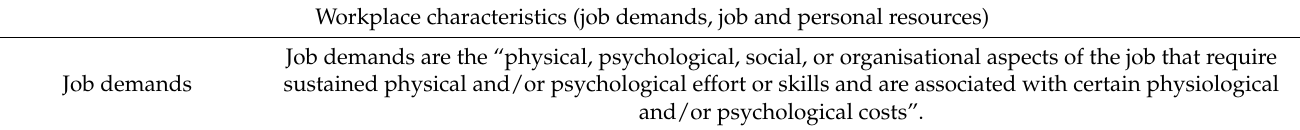
Table A1. Categories of Job Demands Resource Model of Burnout